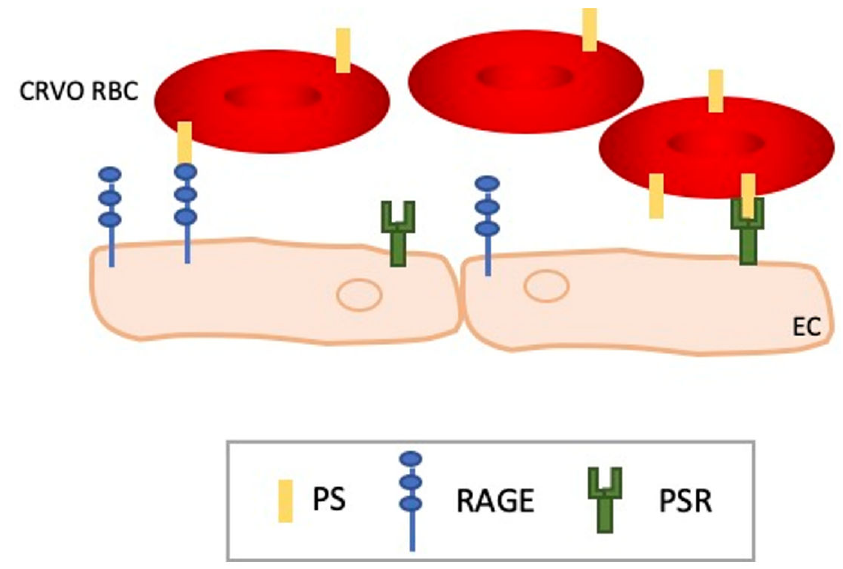
Figure 1. Role of phosphatidylserine exposure in CRVO pathophysiology. PS exposure on CRVO RBCs leads to increase adhesion to endothelial cells through the interaction with PSR and/or RAGE. CRVO RBC adherence to the endothelium contributes to the slowdown of blood flow leading to